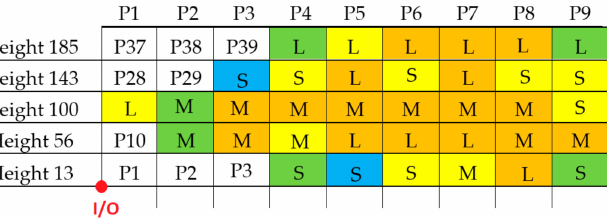
Figure 8. Storage assignment proposal based on minimization of the health risk-based objective function (scenario 3, short rack).